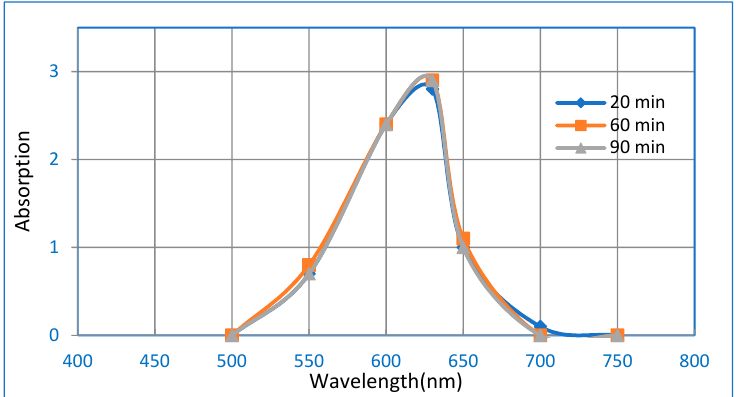
Figure 14. Molecular structure of brilliant green dye.